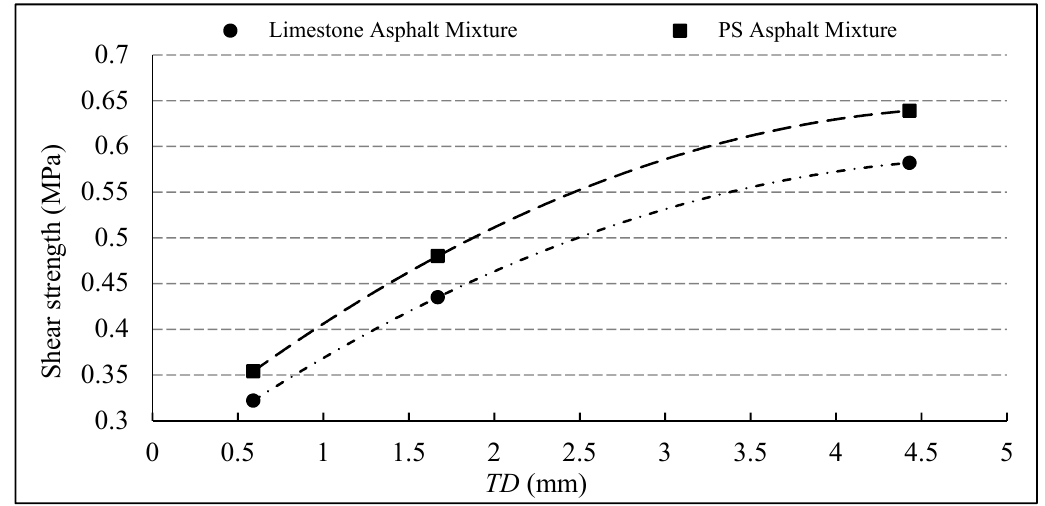
Figure 7. Impact of texture depth on the interlaminar bonding.